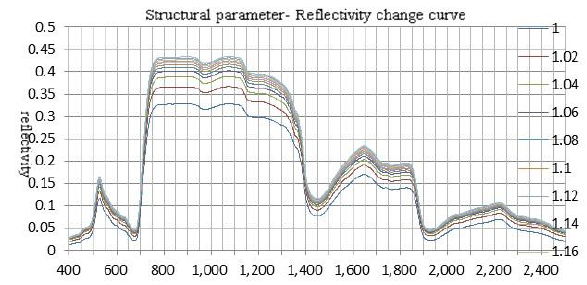
Figure 3. Reflectivity change curve of structural parameter Firstly, the leaf structural paramerter in the model is analyzed and the change scope of the structural parameter is set to be 1- 1.2 with interval of 0.02. The structural parameter change curve shows that the slight change of the structural parameter will cause significant change of leaf spectrum in the near-infrared region and the sensitivity of near-infrared part to the leaf structural parameter is high. When the structural parameter increases, the spectural reflectivity of leaves will increses too (specially in the near-infrared region) and the reflctivity increasment decreases step by step. Because GLIBERTY considers that the leaf structural parameter characterizses the cell layers in leaves, so the change processs complies with the theory that the reflectivity meased on the cell layer increases along with the increase of layer of cells and the therory that the reflectivity measued tends to stablize when the layer of cells increases to a certain amount. Therefore, the accuracy of the structural parameter shall be noted during the application of the model.